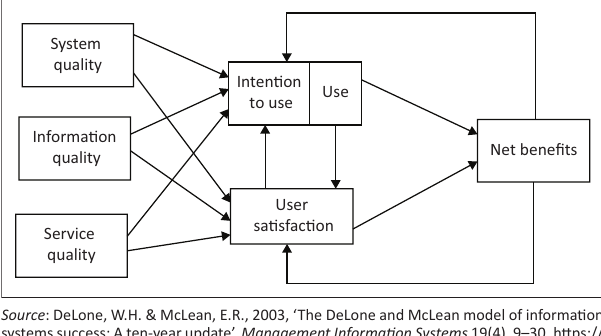
FIGURE 3: The updated D&M IS success model.